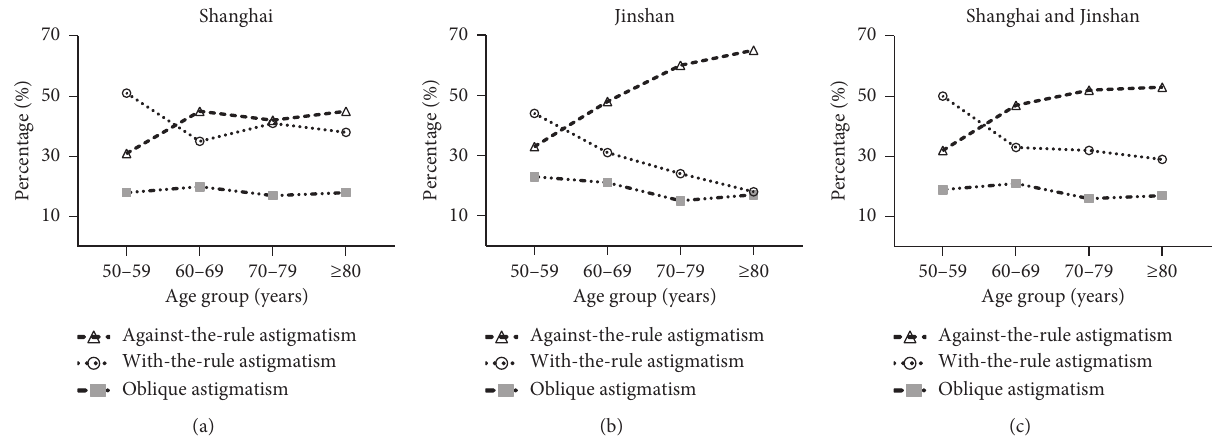
Figure 4: Percentages of with-the-rule, against-the-rule, and oblique corneal astigmatisms in the 4 groups. Table 4: Associations of AL with systemic and ocular